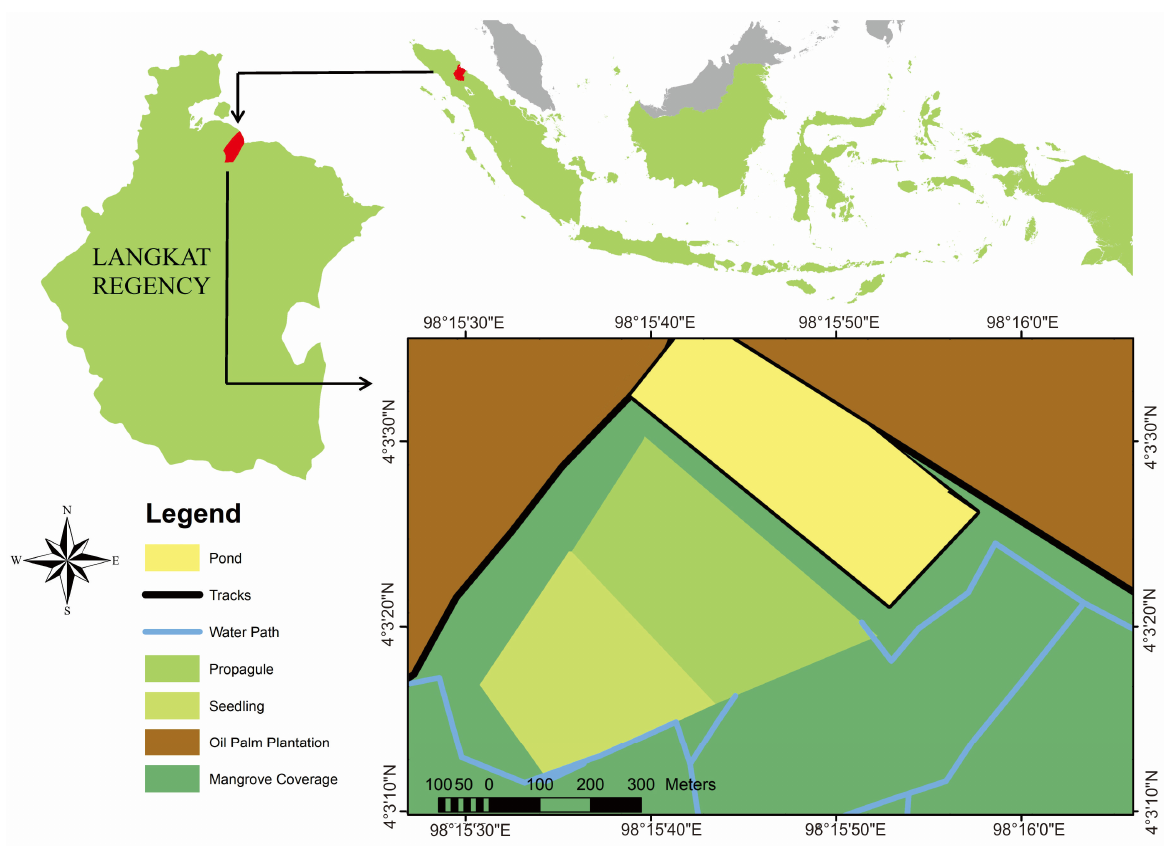
Figure 1. Map of study location of mangrove restored area in Lubuk Kertang Village, West Brandan District, Langkat Regency, North Sumatra, Indonesia.